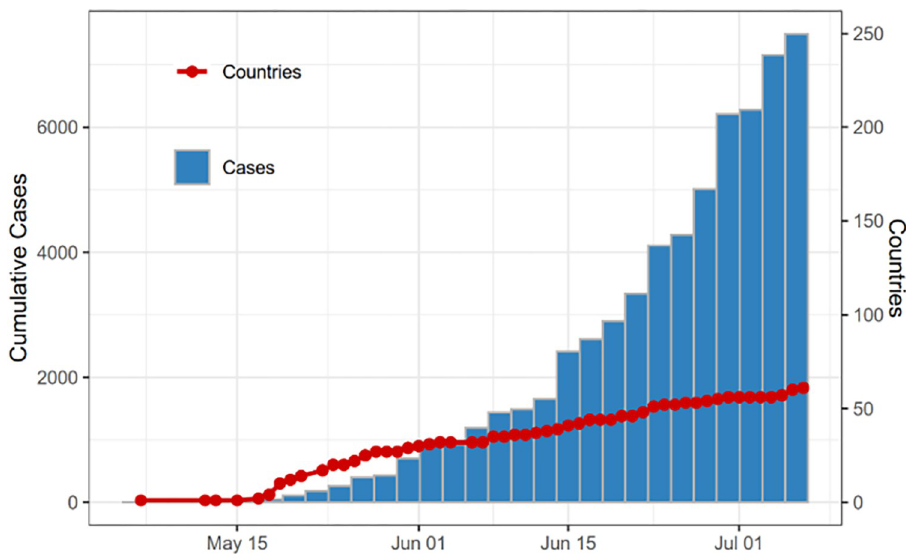
Fig 1. Number of cumulative confirmed cases and number of countries who have reported confirmed cases. Source: Global.health Monkeypox (accessed on 2022 June 9).